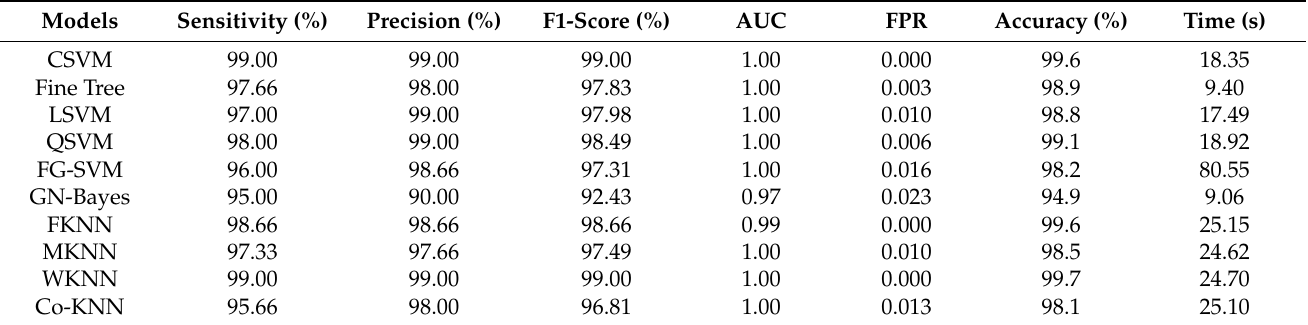
Table 11. Classification results using MEWOA on Fine-tuned Nasnet deep features for MIAS.